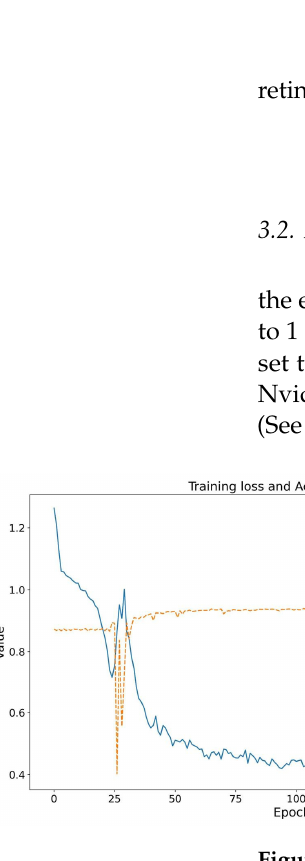
Figure 7. Training loss and accuracy in datasets.